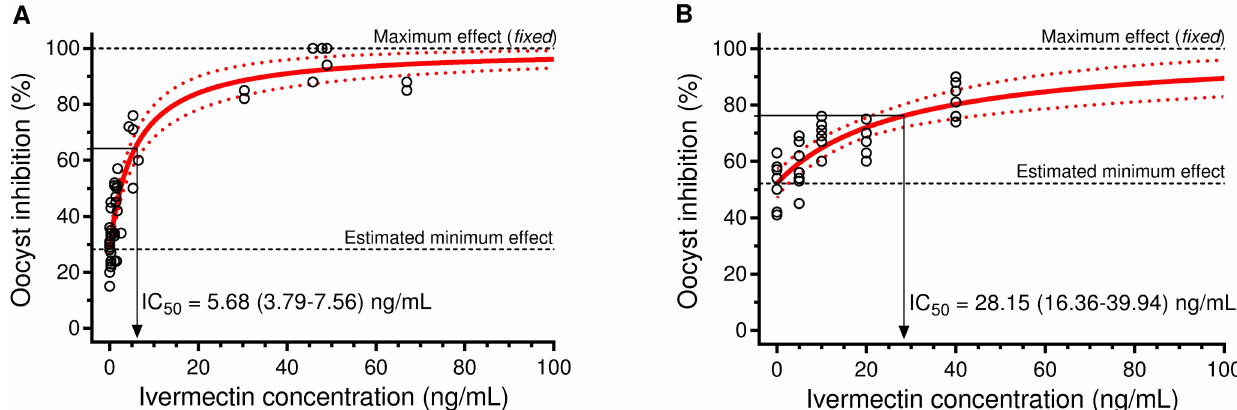
Fig 4. Activity of IVM on P . vivax infections in An . aquasalis . P . vivax oocyst inhibition in An . aquasalis when ingesting plasma from human volunteers receiving standard single oral dosing of IVM (A) or whole blood spiked with IVM (B).